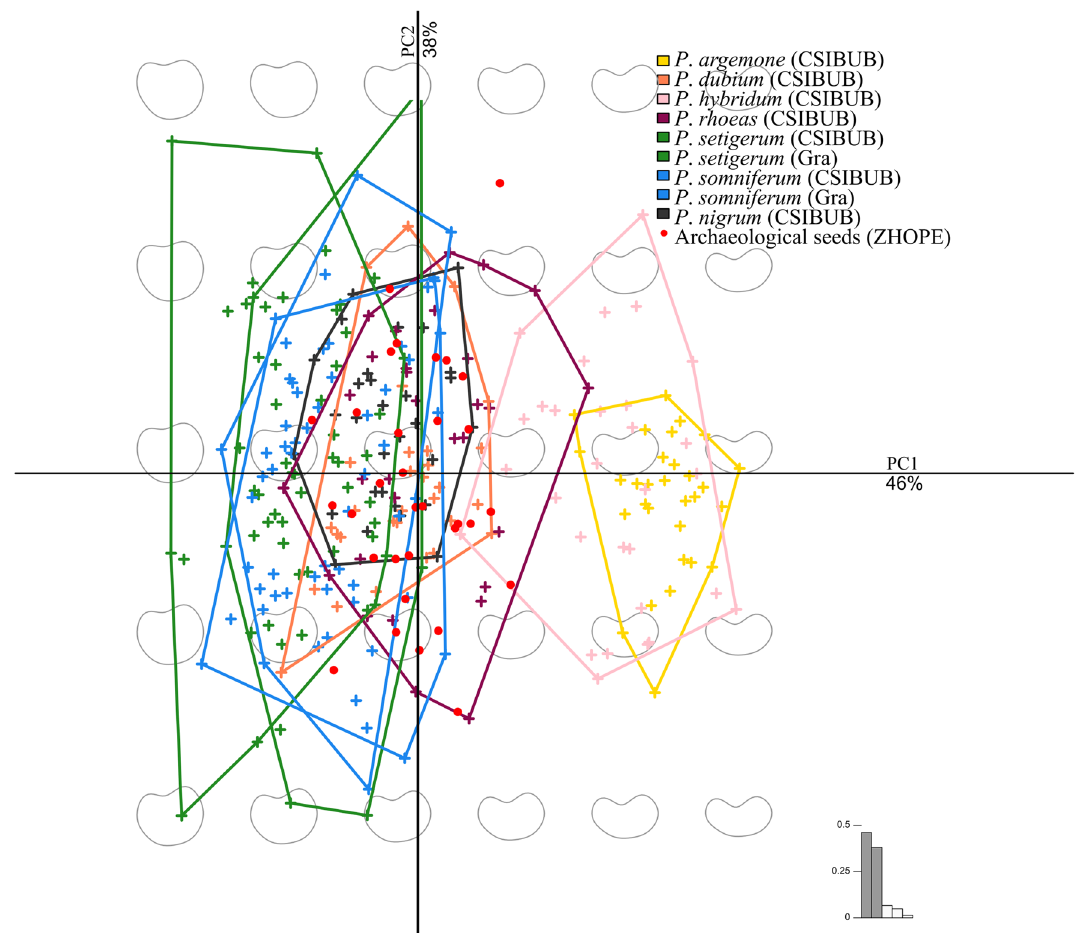
Figure 2. Principal component analysis performed on shape coefficients. The first two components are shown here gather 84% of the total shape variability. Archaeological seeds (red dots) are added as supplementary individuals, i.e. reprojected, on this biplot.